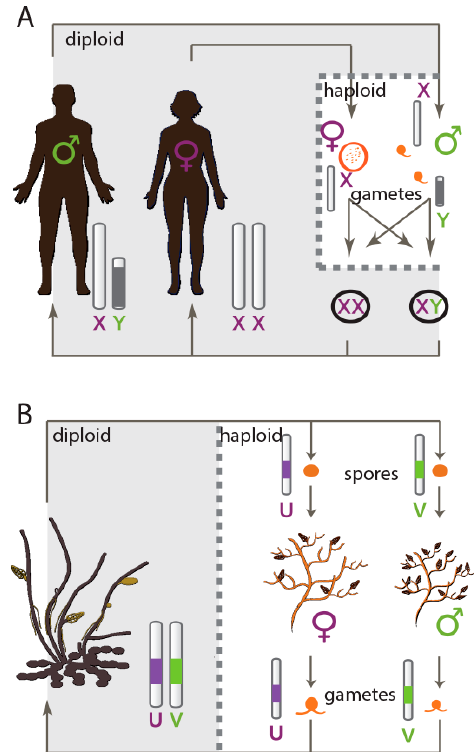
Figure 1. Comparisons of XX/XY and UV sex determination systems. ( A ) XX/XY sex determination system. The sexual individuals are diploid, and the sex of an offspring is determined after fertilization, depending on the sex chromosome contributed by the sperm. Please note that the haploid phase of the life cycle is limited to the gametic stage. Note also that ZW systems function in a similar manner to XY systems, with diploid phase sex determination, but it is the female that is the heterogametic sex; ( B ) UV sex determination system. The diploid, asexual generation (sporophyte) carries both the U and the V sex chromosomes which are passed on to the haploid spores after meiosis. Spores that receive the V sex chromosome develop into a male gametophyte whereas spores carrying U sex chromosome will produce a female gametophyte. Egg and sperm produced by the gametophyte fuse to return to the diploid generation. In UV sex determination systems, the sexual individuals are haploid and sex chromosomes function in the haploid state.